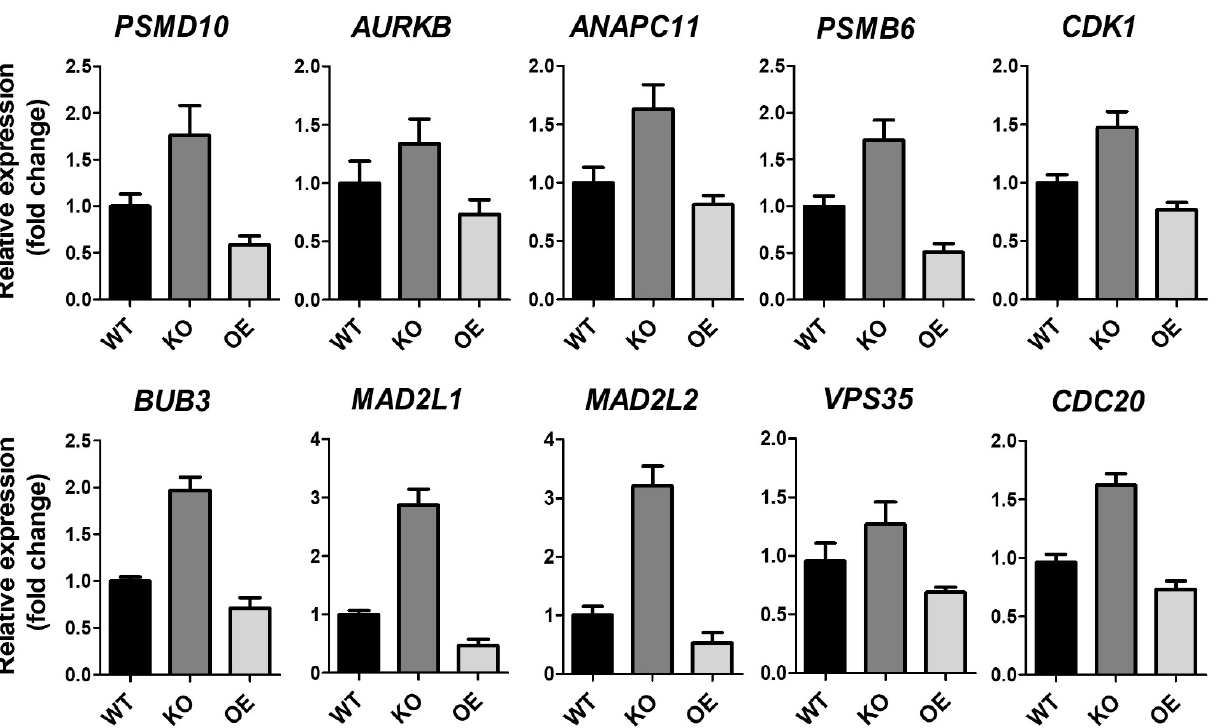
Figure 2. RNA expression of ZK3-KO and reference cells. Validation of anaphase-associating genes from HCT116 (WT), ZK3-KO (KO), and ZKSCAN3-overexpressing (OE) HCT116 cells transduced by Ad-ZK3/HA, using qRT-PCR. Data from three independent experiments are shown as the means ± SD. Statistical significance was determined using the Kruskal–Wallis test ( p < 0.01).